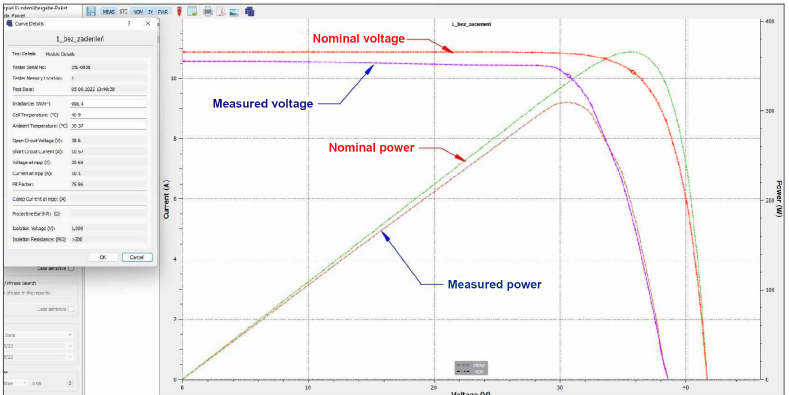
Figure 3. Measured characteristics of the module shown in Figure 2 compared to the nominal one. The age-caused deterioration of the performance is clearly visible.